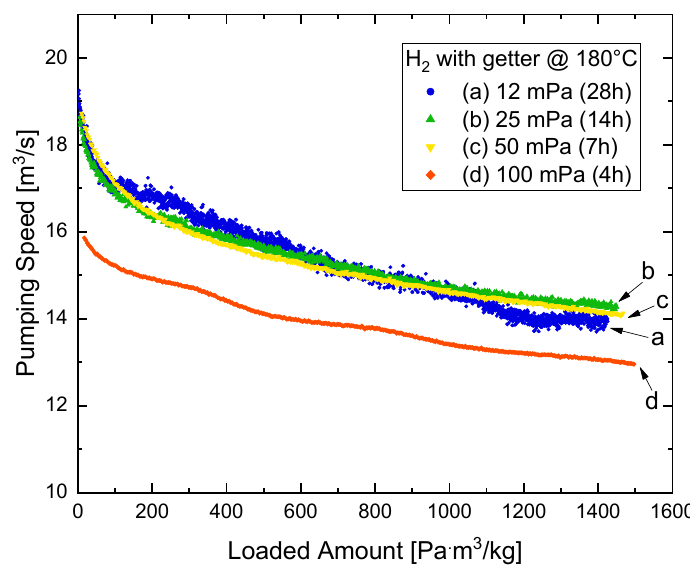
Figure 10. Pumping speed curves at different pressures with the growing inventory of H 2 with ZAO ® at 180 °C. Different pressures were established by different constant mass flows resulting in different durations to reach the same inventory. The effect of the decreasing pumping speed at higher pressures, caused by diffusion limitation from the getter surface into the bulk, becomes significant only for pressures > 50 mPa.